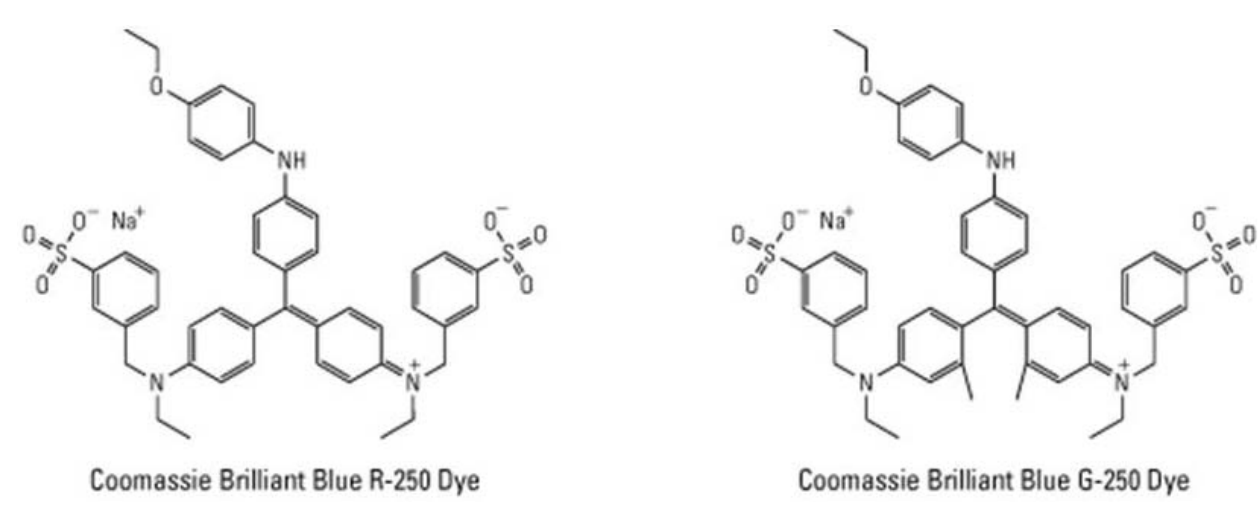
Figure 2. Chemical structures of Coomassie brilliant blue R-250 (left) and G-250